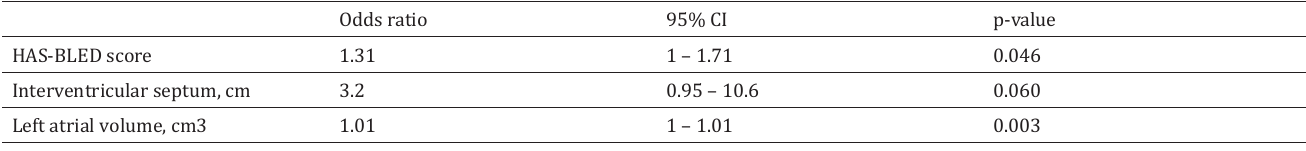
Multivariate analysis of predictors of left atrial appendage thrombus according to transesophageal echocardiography